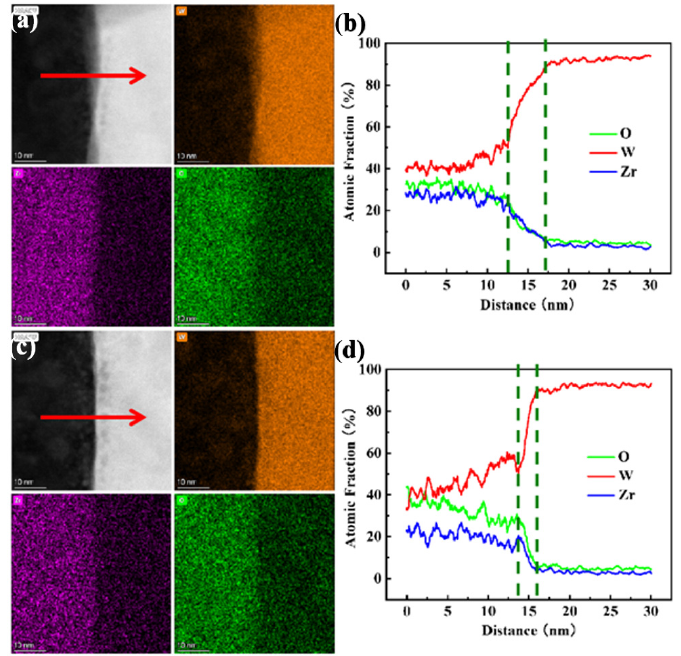
Figure 4. The EDS elemental mapping (W, Zr, O) and line profile of irradiated ( a , b ) and unirradiated ( c , d ) phase boundary regions between the ZrO 2 phase and the W matrix.